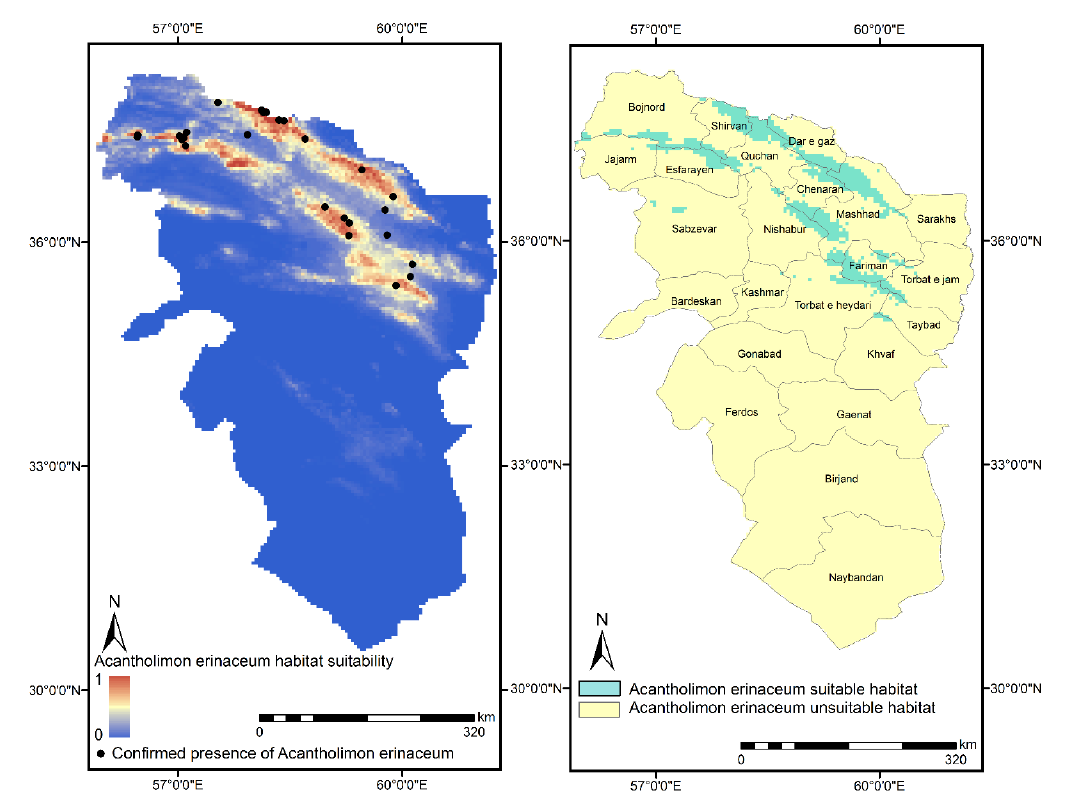
Fig. 6: Habitat suitability of Acantholimon erinaceum and its suitable habitats in the cities of Khorasan